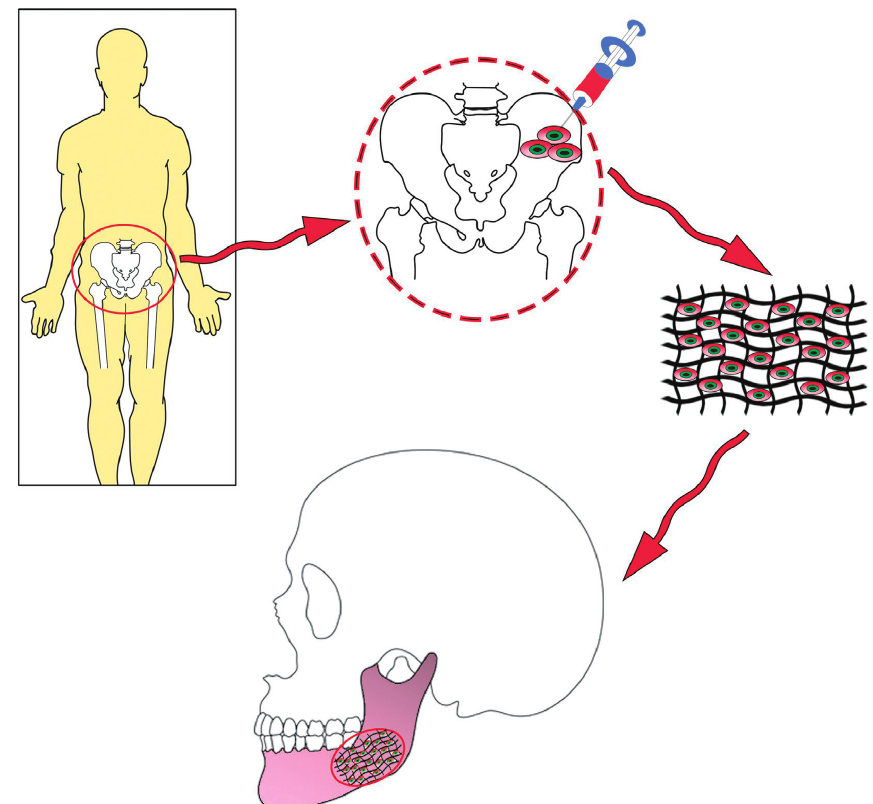
Figure 1: Isolation of autologous stem cells from some easy access tissues including bone marrow. There is a possibility to expand those bone marrow-derived stem cells in defined culture media on the scaffold to produce enough cells for craniofacial and dental tissue engineering